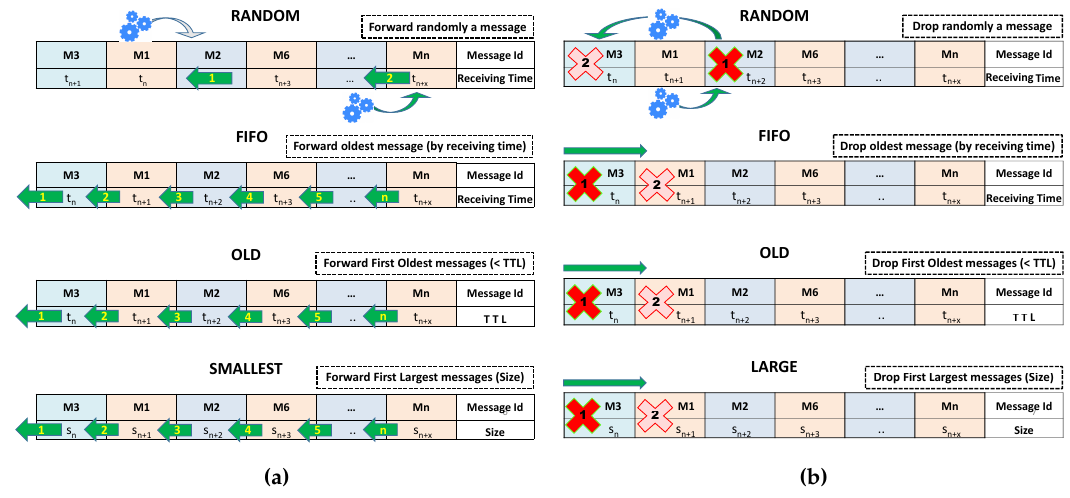
Figure 2. Message forwarding ( a ) and dropping ( b ) policies in the local